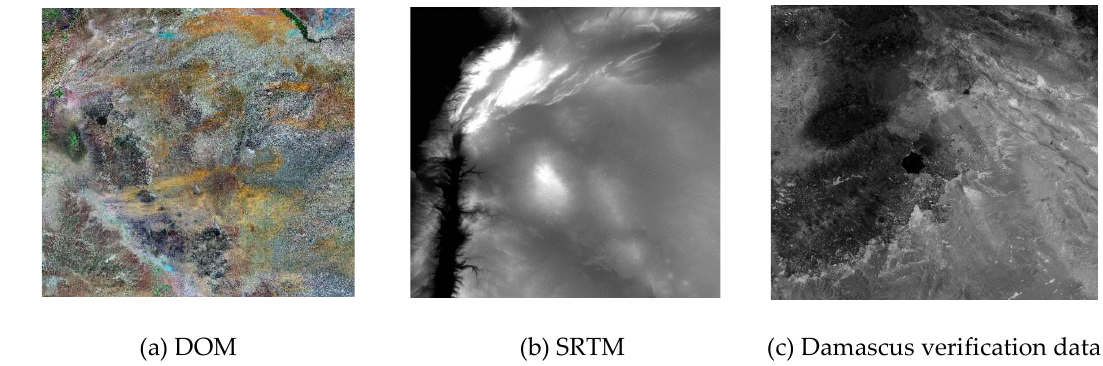
Figure 7. Damascus regional control and validation data.